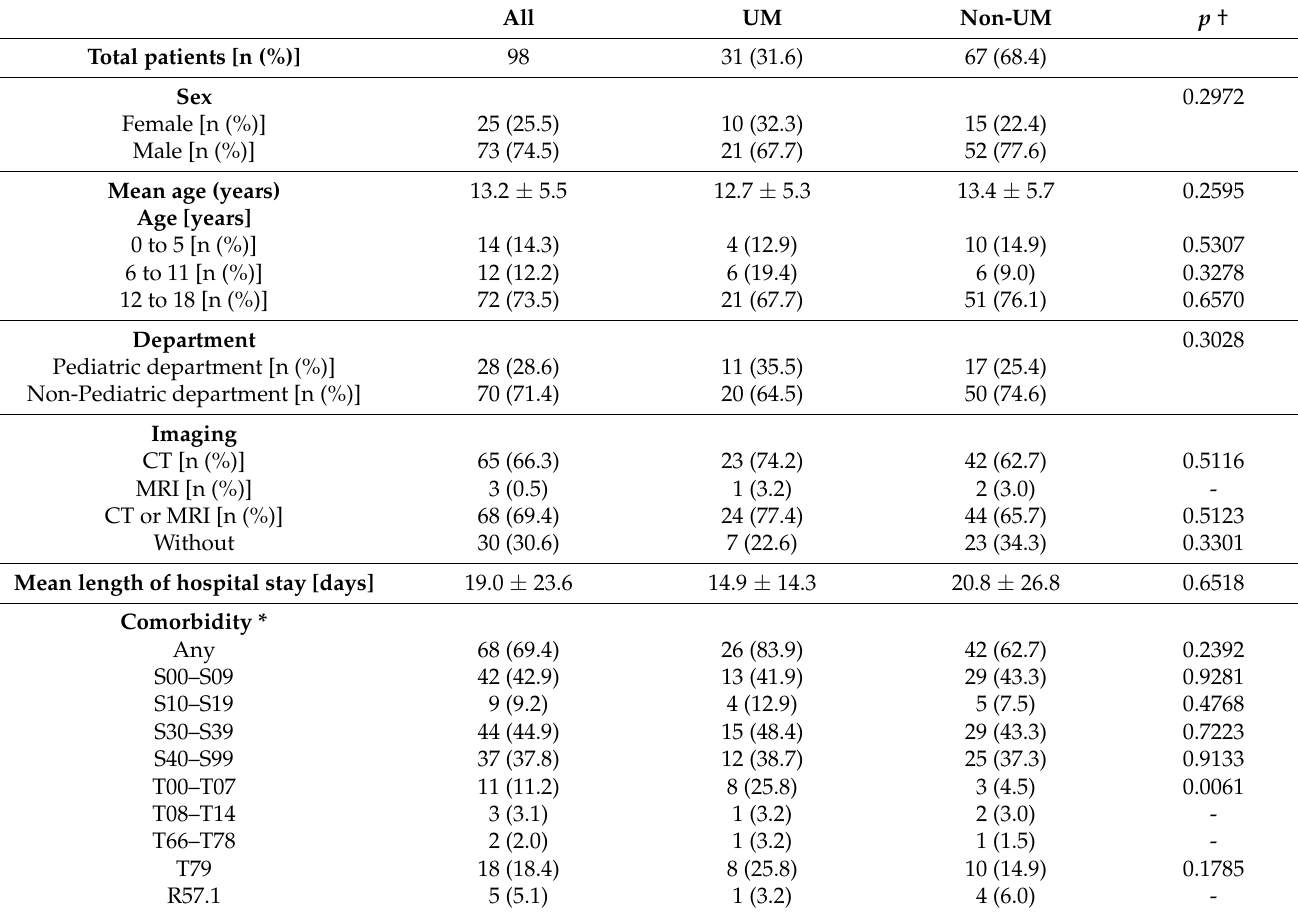
Table 5. Patient characteristics (subgroup with OPS 5-340.0 or 8-144, drainage of the pleural cavity).